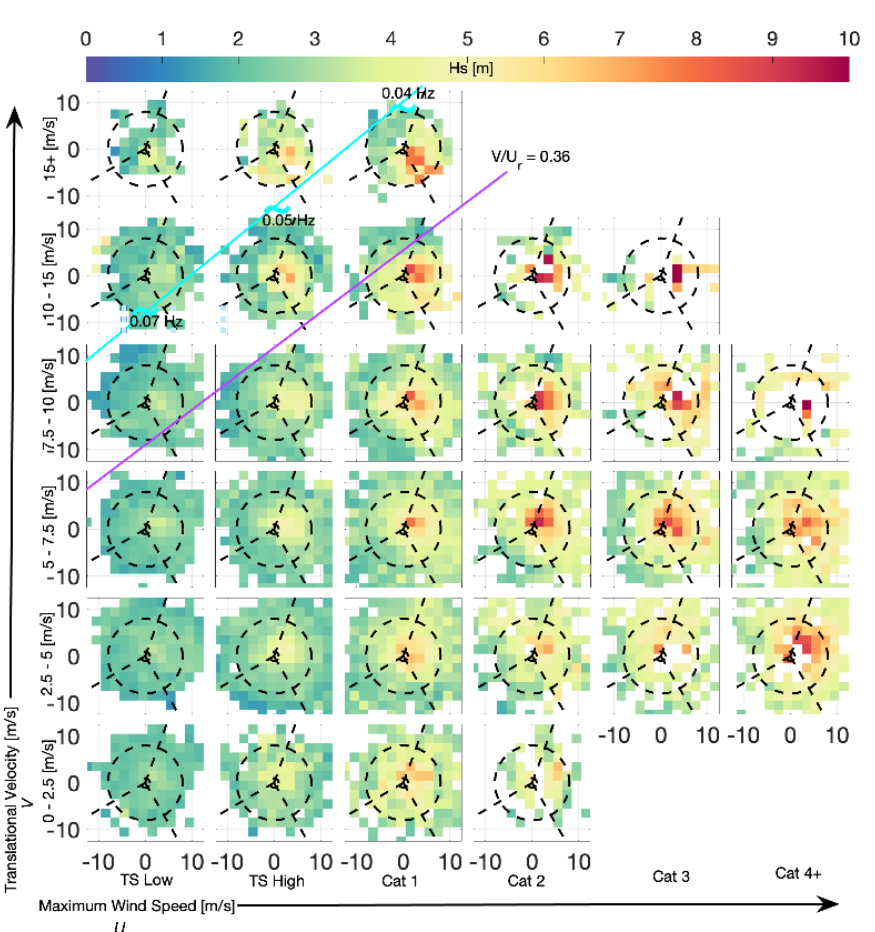
Figure 4. Altimeter observed wave height shown in color. Each subplot as in Figure 3 without interpolation or contour lines. Data are binned by S-S category from left to right. From bottom to top, data are binned by TC translation velocity. The color scale indicates significant wave height from 0-10 m. The cyan line shows the approximate correspondence of linear wave phase speed (x-axis) to group speed (y-axis). The wave frequency is given at 3 locations along the line. The purple line is the approximate location of the resonance condition of Kudryavtsev et al. 2015.